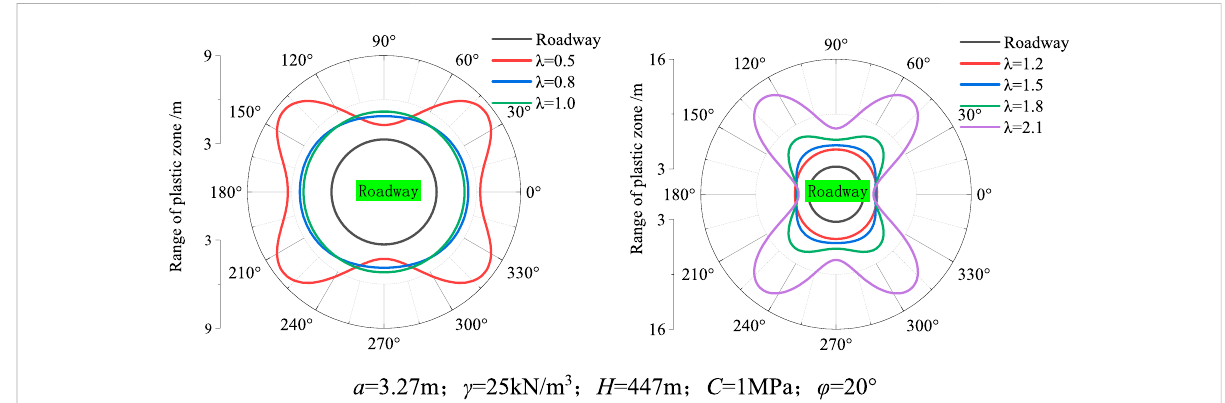
FIGURE 5 Boundary of the plastic zone of surrounding rock in the road at different lateral pressure coef fi cients.